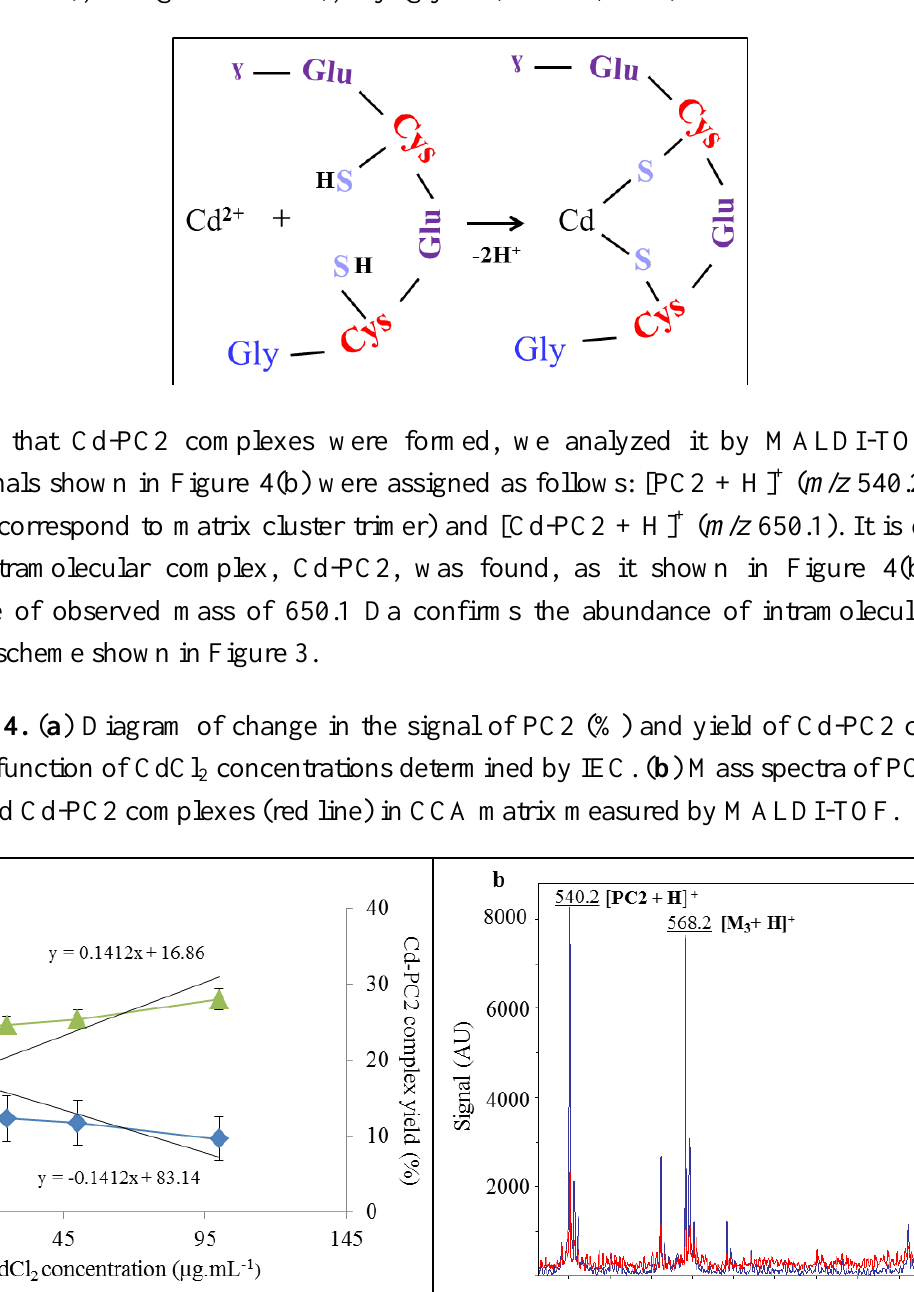
Figure 3. Model of complex between cadmium Cd(II) ion and one molecules of PC2. Cys (cysteine), Glu (glutamic acid), Gly (glycine) and S (sulfur).